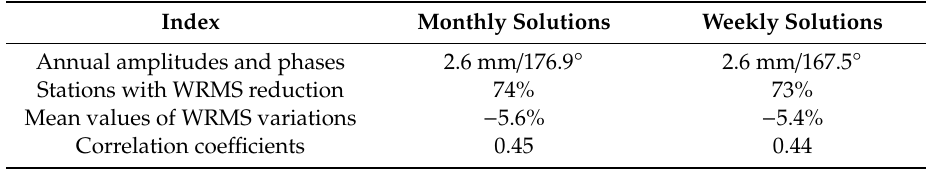
Table 3. Statistical results of the GNSS and GGFC with di ff erent sampling